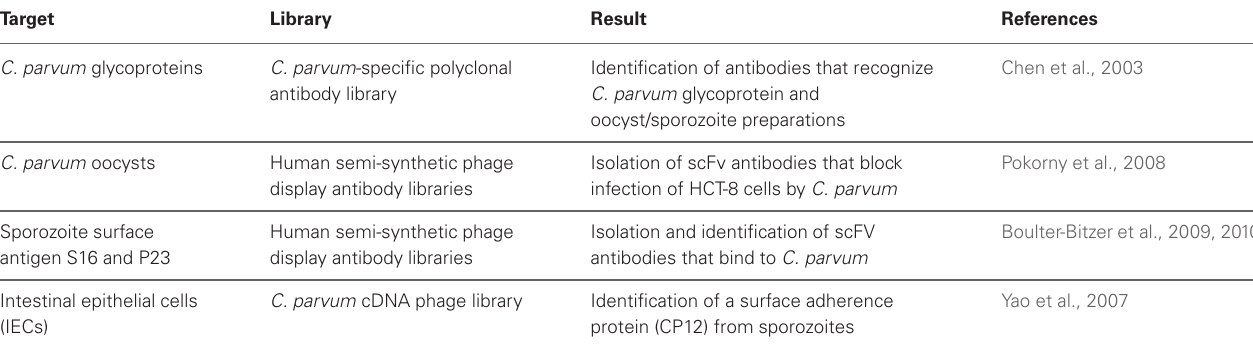
Table 3 | Summary of phage display applications in C. parvum